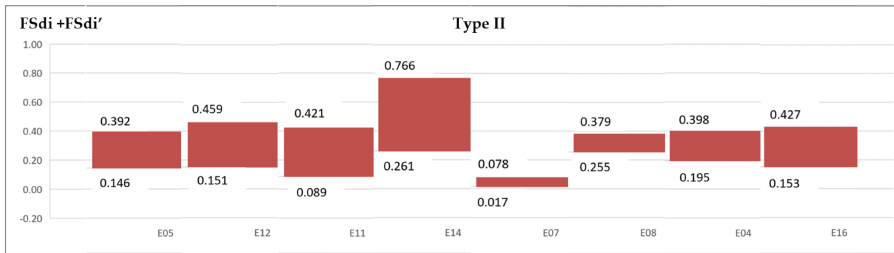
Figure 12. Area delamination factor range Type I (FSdi + FSdi’).